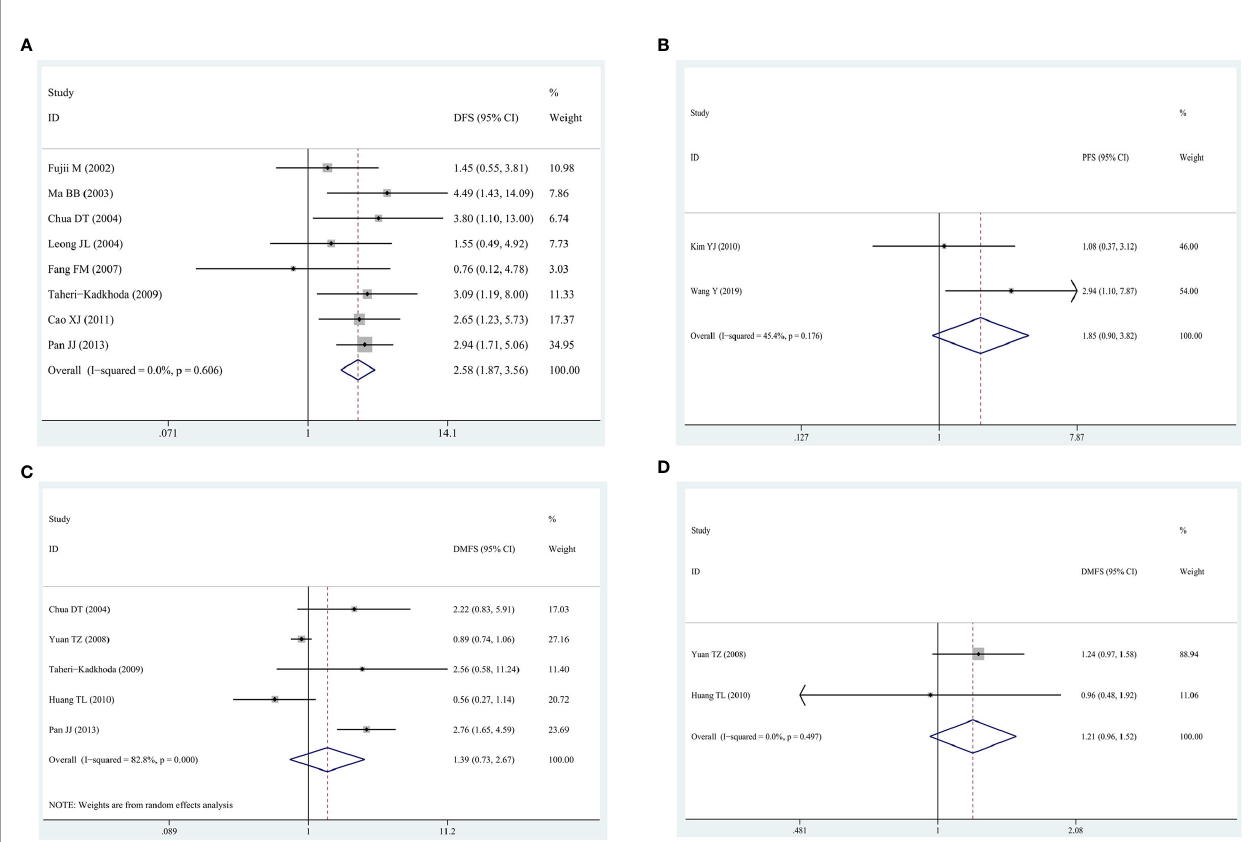
FIGURE 3 | The forest map for relationship between EGFR/p-EGFR and DFS/PFS/DMFS in NPC. (A) EGFR and DFS. (B) EGFR and PFS. (C) EGFR and DFMS. (D) p-EGFR and DMFS.